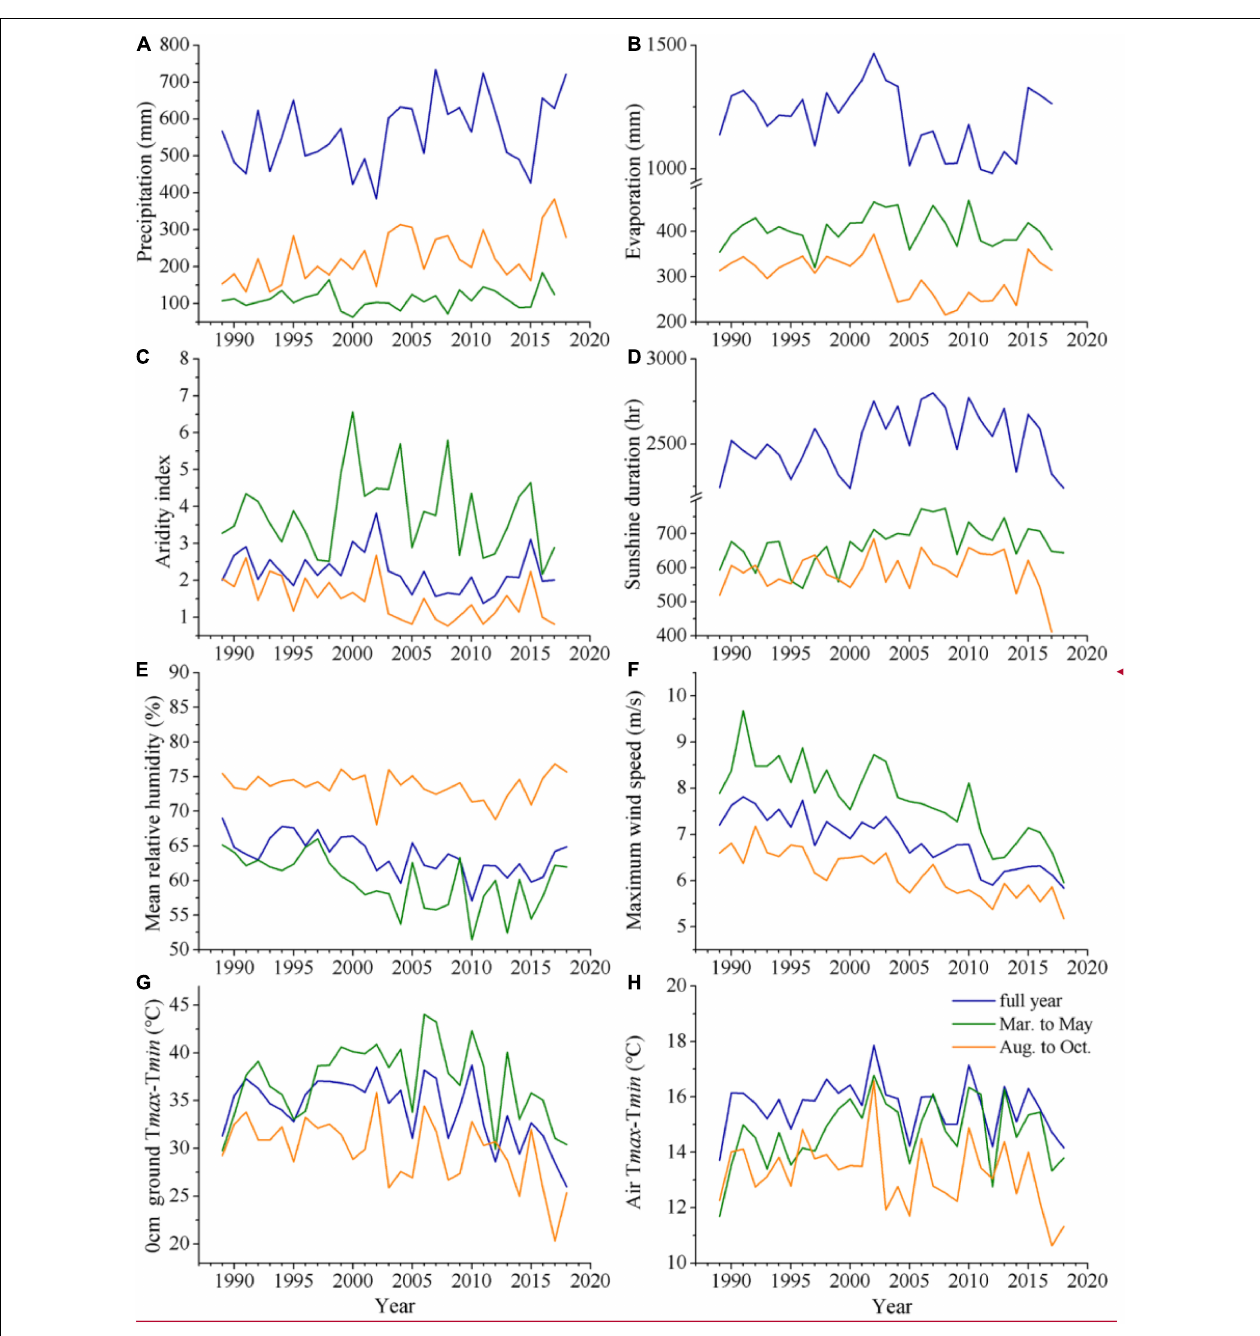
FIGURE 2 | Variations in accumulation precipitation (A) , evaporation (B) , aridity index (defined as evaporation/precipitation) (C) , sunshine duration (D) , mean relative humidity (E) , maximum wind speed (F) , 0 cm ground temperature difference between day and night (G) and air temperature difference between day and night (H)